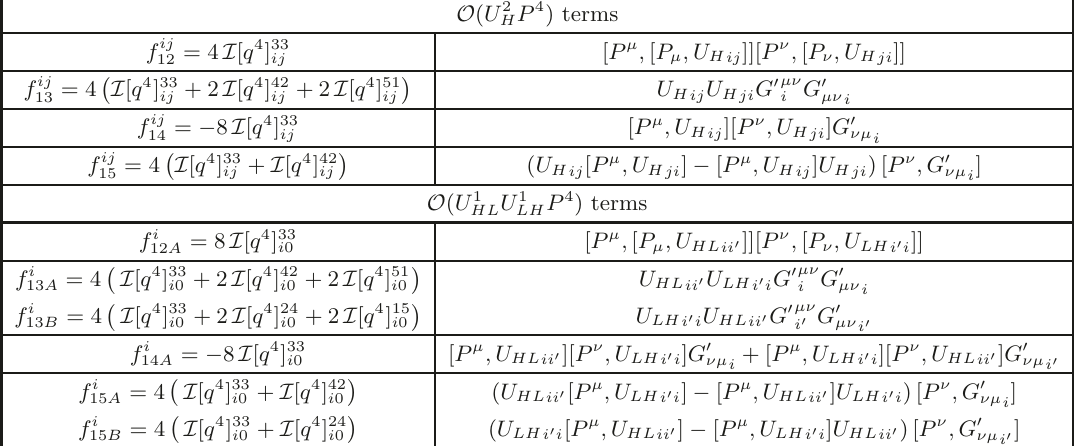
Table 3 . Universal coefficients f ij